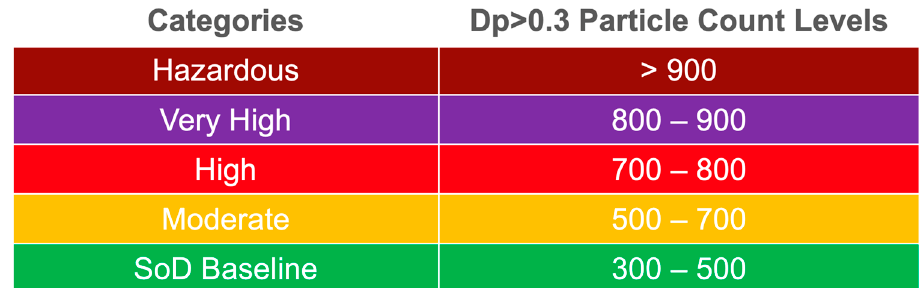
Figure 8. The number of particulates larger than PM 0.3 (Dp > 0.3) data from three selected sensors is presented. The high exposure peaks are shown in red circles. AS4 was worn by the physician, AS3 was placed closest to the patient, and AS1 was placed in the hallway outside the dental operatory bay. The spikes associated with the drilling procedure are immediately detected by AS4, putting the physician at the highest risk of transmission. Some spikes are detected by AS1, which shows that aerosolized particles are traveling across the hall and potentially contaminating other locations. The graphs have been color-coded in five categories, which are defined in Figure 9.